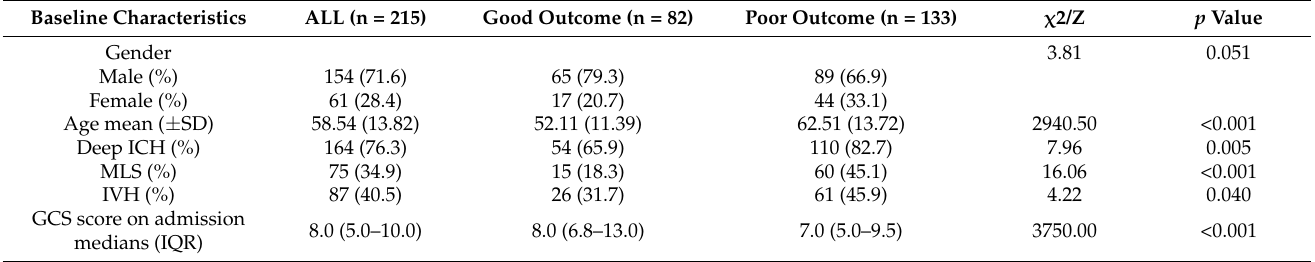
Table 1. Baseline demographic, clinical, and radiological characteristics of training and test datasets.